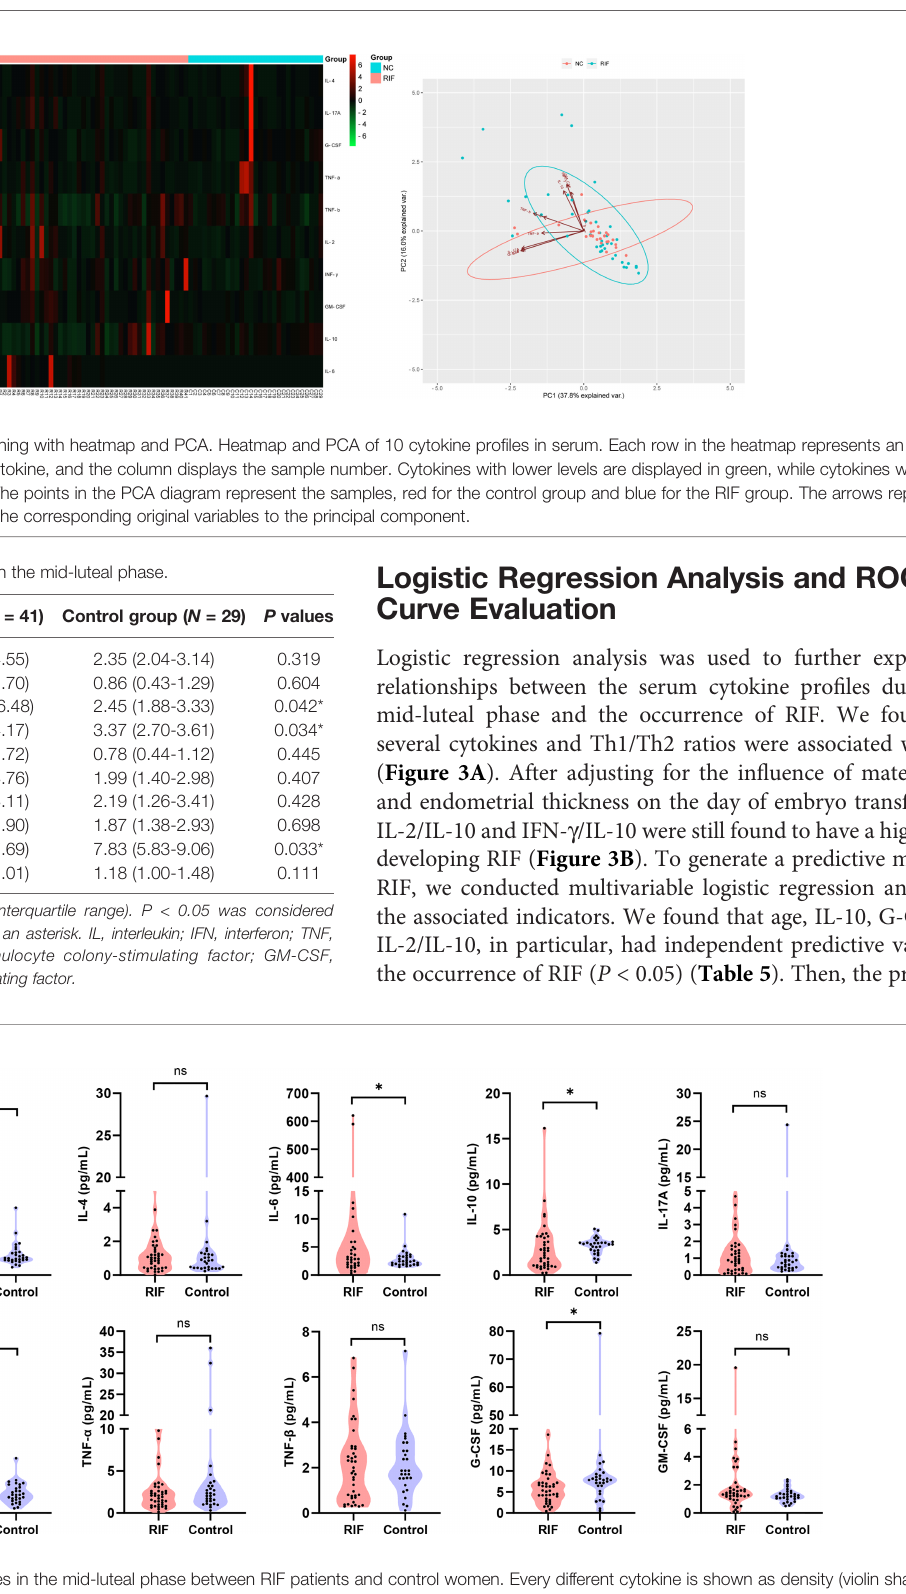
FIGURE 2 | Serum cytokine pro fi les in the mid-luteal phase between RIF patients and control women. Every different cytokine is shown as density (violin shap), and data are shown as the median (interquartile range) for the two groups. * P < 0.05; ** P < 0.01; *** P < 0.001; **** P < 0.0001; NS, not signi fi